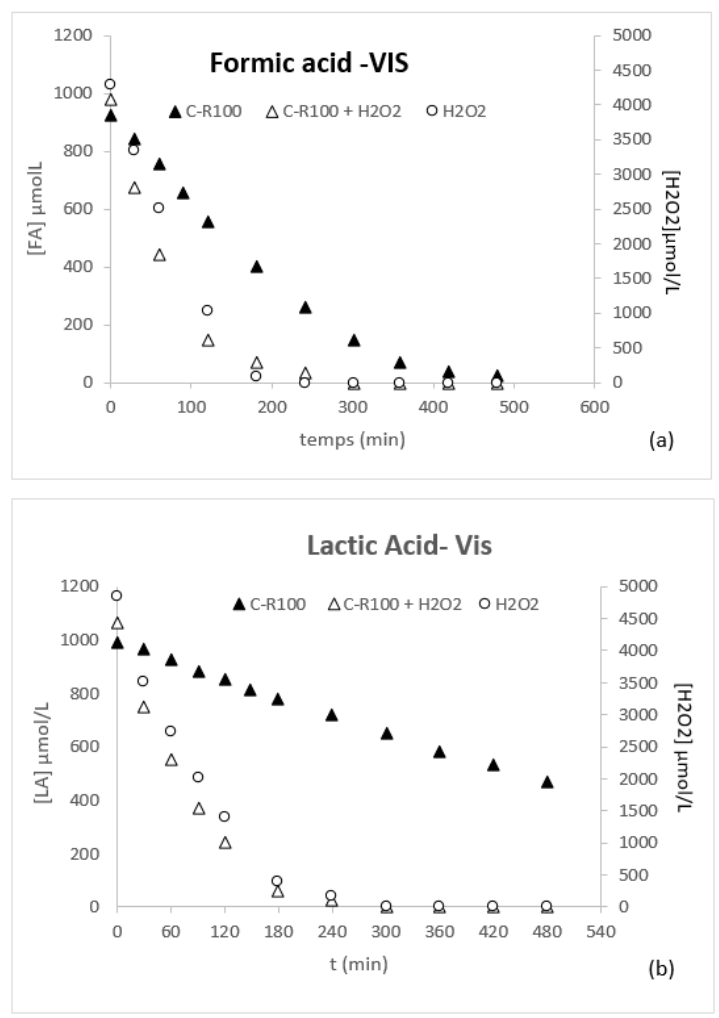
Figure 8. Degradation of FA and H 2 O 2 ( a ) and LA and H 2 O 2 ( b ) as a function of time in the presence of C-R100.